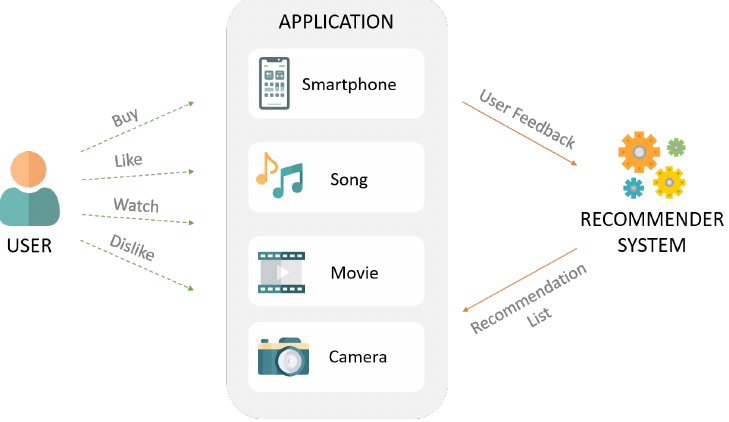
Figure 1. Illustration of the logical process of a recommendation